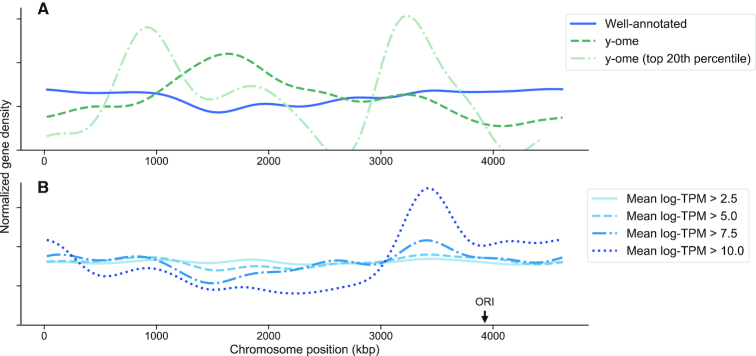
Gene expression by location on the chromosome. (A) The y-ome genes are enriched in the termination region of the E. coli chromosome, opposite the ORI. However, the y-ome genes in the top 20th percentile of expression (mean log-TPM > 7.57) are enriched both near the ORI and the termination region. (B) Highly expressed genes are known to be enriched around the ORI (16), which we confirmed by plotting density of genes in the chromosome with increasing thresholds of mean gene expression (mean log-TPM) across the compendium of RNA-seq data for 78 conditions.